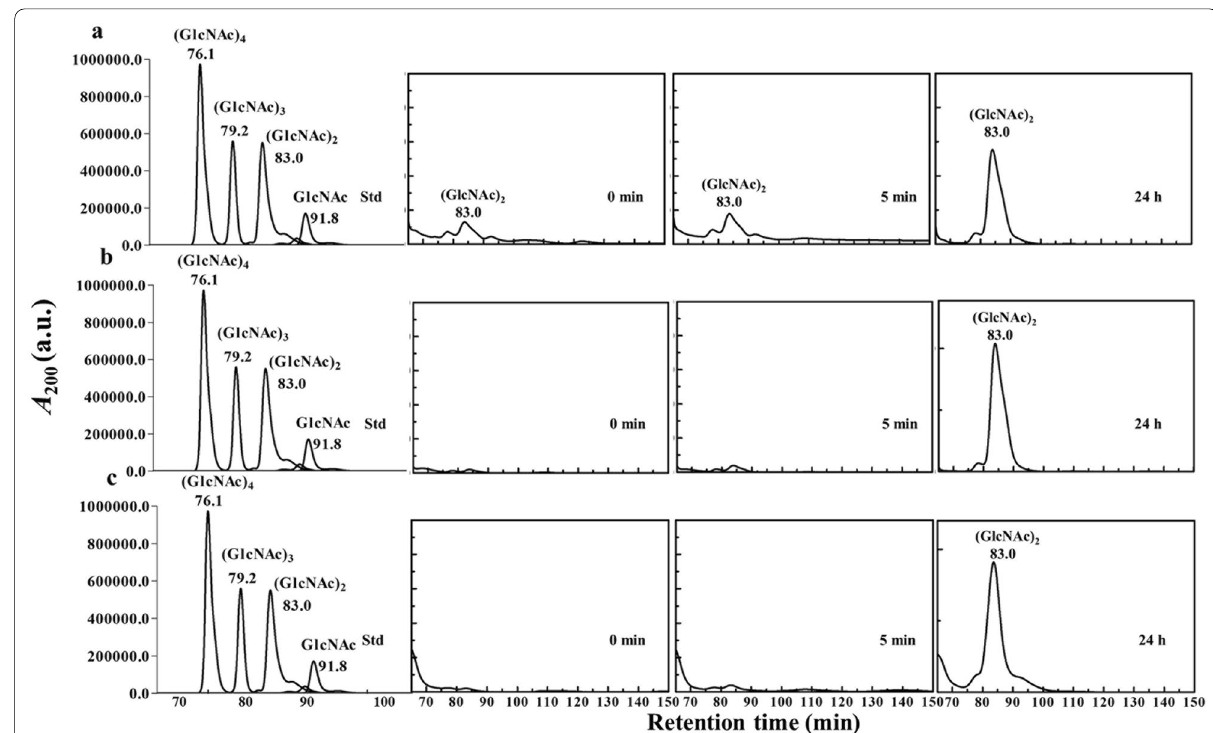
Fig. 3 HPLC analysis of chitin hydrolysis by Vh ChiA. a Squid pen chitin, b shrimp chitin, c crab chitin. Each reaction sample of 20 μL (carried out as described in text) was applied to a TSK Gel G2000 PW column connected with a Shimadzu HPLC system. Left panels are standard chitosugars (GlcNAc) – (GlcNAc) 4 run under the same conditions as the reaction